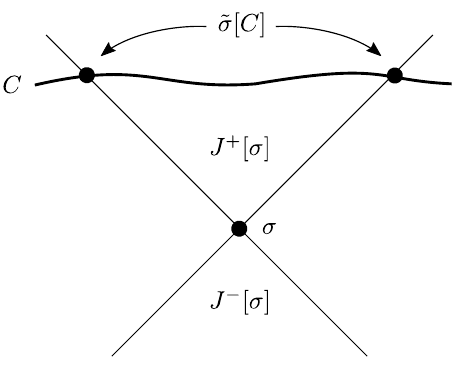
Figure 5 . We de(cid:12)ne the representatives of a surface (cid:27) on Cauchy slice C as the intersection of C with the boundary of J [ (cid:27) ] (cid:17) J + [ (cid:27) ] [ J (cid:0) [ (cid:27) ]. We display the case where there are two representatives of (cid:27) on C